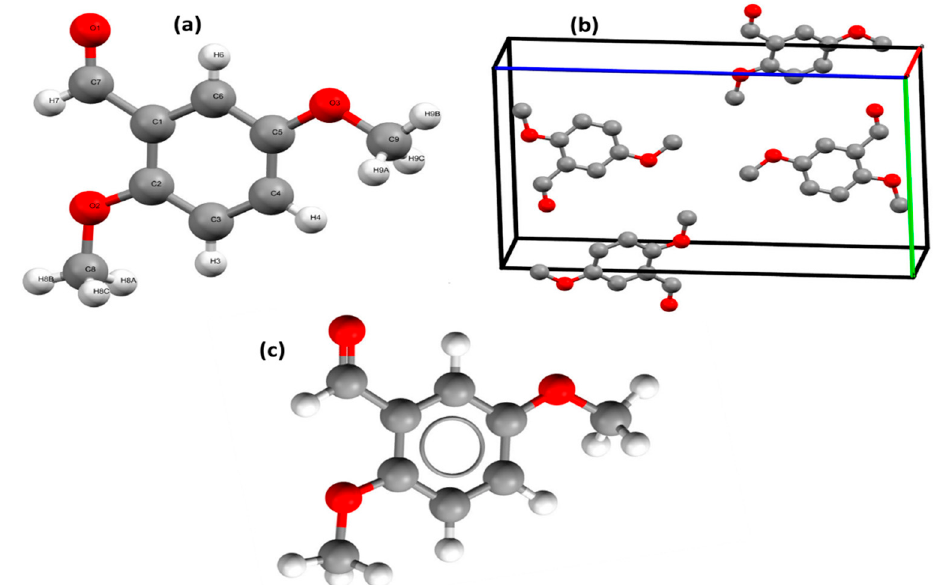
Figure 1. ( a ) ORTEP drawing of exo -2,5-dimethoxybenzaldehyde. ( b ) Packing unit cell with four crystallized exo -2,5-dimethoxybenzaldehyde molecules. ( c ) B3LYP/6-311G(d,p)-optimized structure of exo -2,5-dimethoxybenzaldehyde. Table 2. Density functional theory (DFT)-calculated angles ( o ) and bond lengths (Å) compared to the corresponding X-ray di ff raction (XRD) experimental results (exp.